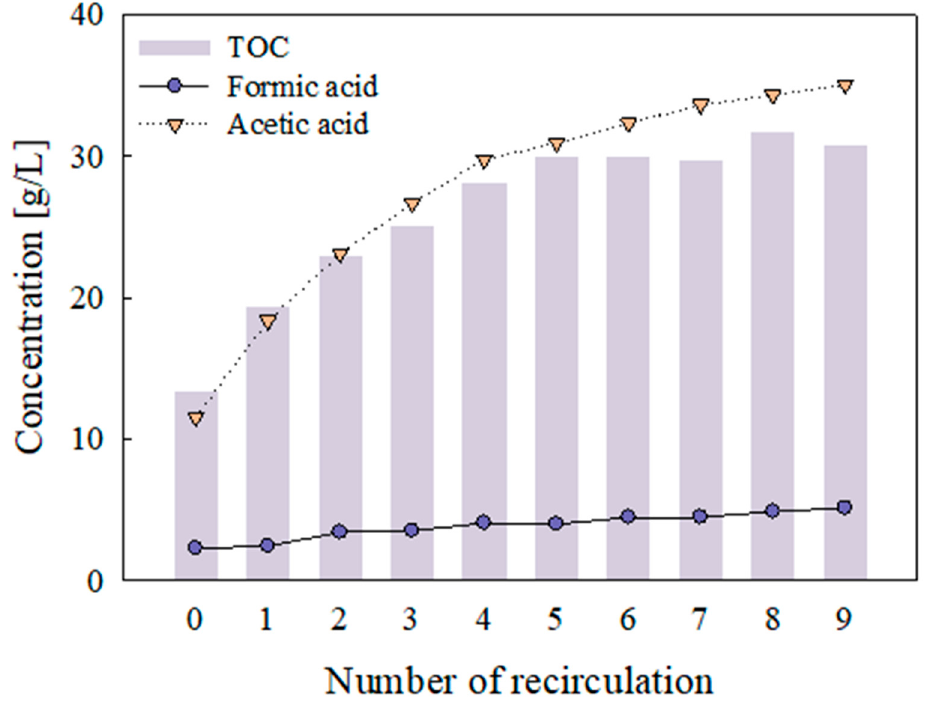
Figure 1. Concentration of organic acids and TOC in bioliquid.